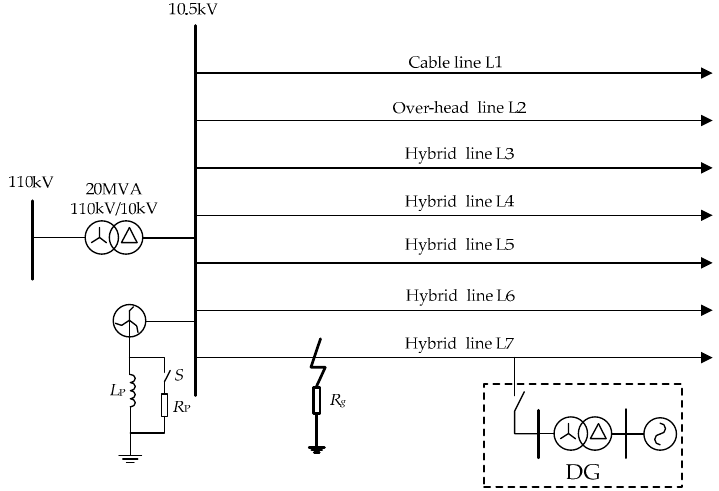
Figure 9. Simulation model of RGDN with distributed sources.